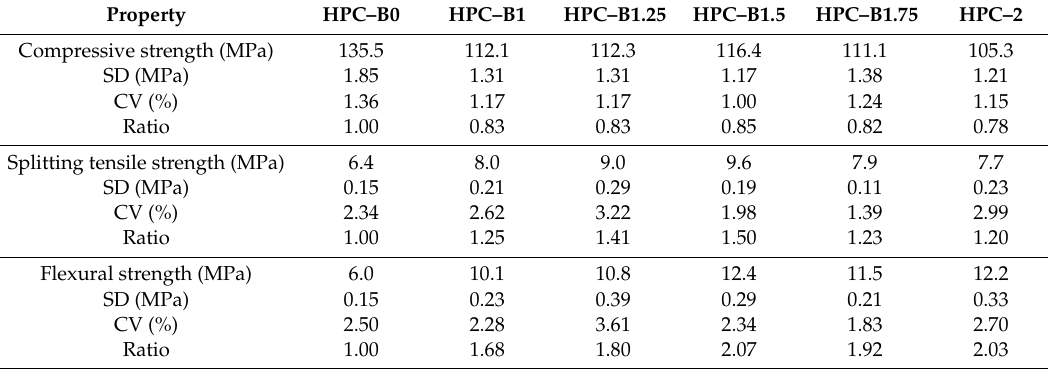
Table 4. Mechanical properties of high performance concretes